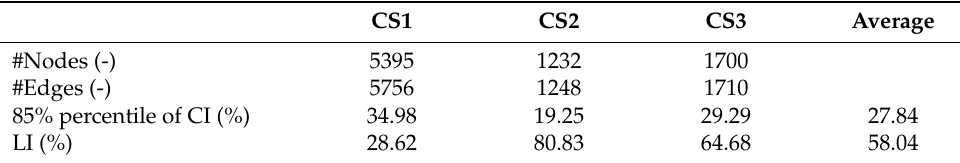
Table 6. Results of the graph analysis for sewer